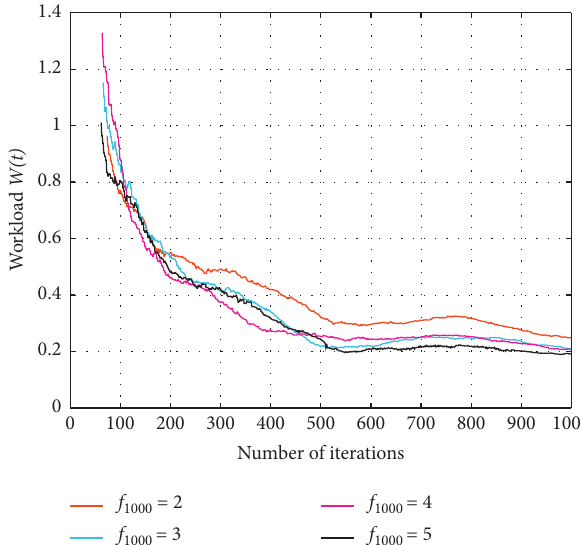
Figure 6: Comparing the performance of the proposed algorithm in terms of the workload, W ( t ) , as the frequency of territorializing varies.